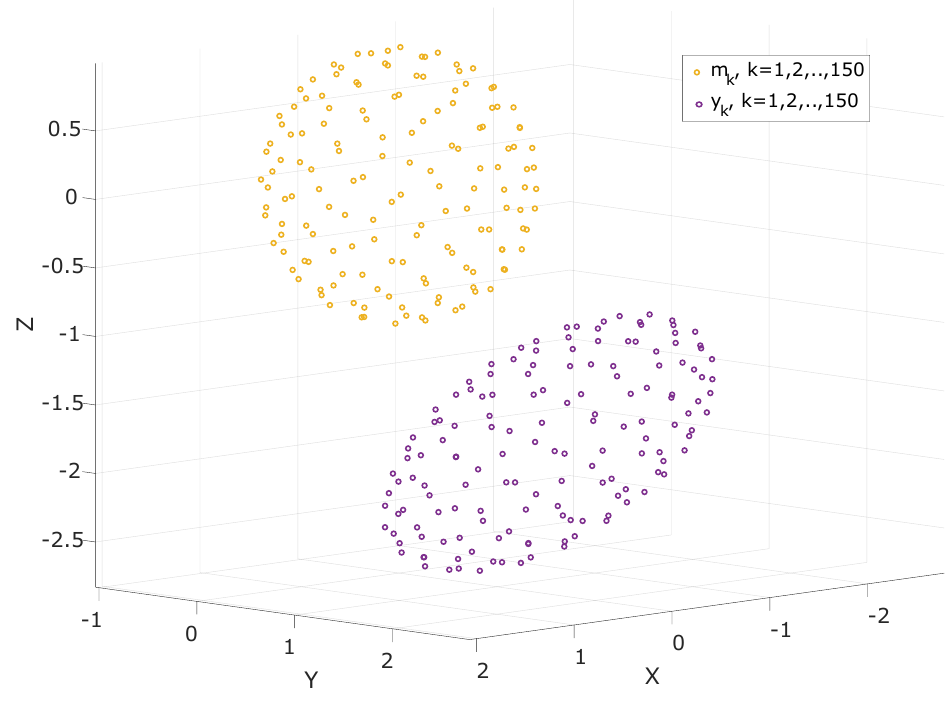
( a ) Synthetic dataset generated using Algorithm 8 for K = 150. Figure 1. Cont